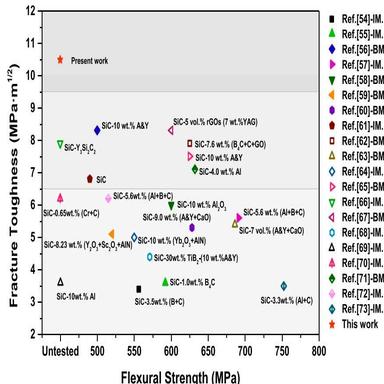
Performance comparison diagram for the present SiC matrix composites and the reported in the literature. Note: A&Y are Al2O3 and Y2O3; GO is graphene oxide.